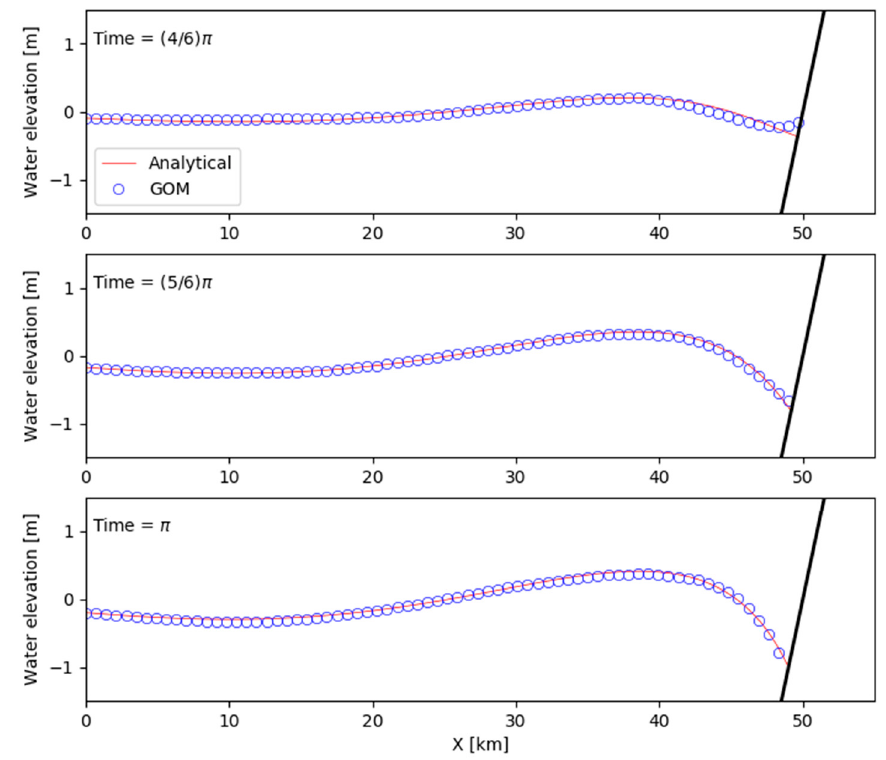
Figure 16. Comparison of wave profiles as predicted by theory (solid red lines) and numerical model (blue circles) of wetting and drying at time = 2 π / 3 to π .